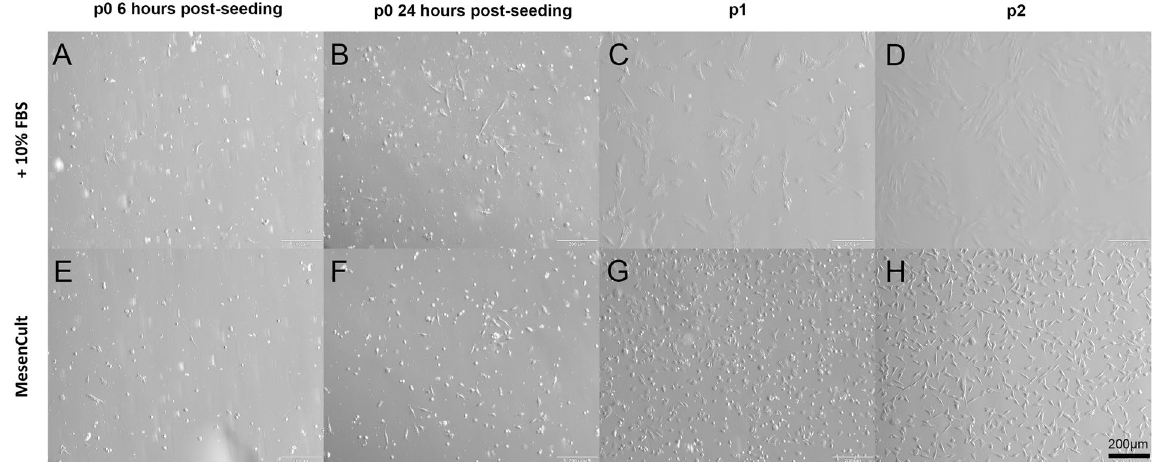
Figure 1. Morphology of adherent isolated pLSCs at 6 h ( A,E ) and 24 h post-seeding ( B,F ), and at passage 1 ( C,G ) and 2 ( D , H ) of culture. PLSC grown in serum-supplemented medium (top row) and serum-free conditions (bottom row) demonstrated adherence to tissue culture plastic and presented a spindle-shaped morphology. Scale bar = 200 μ